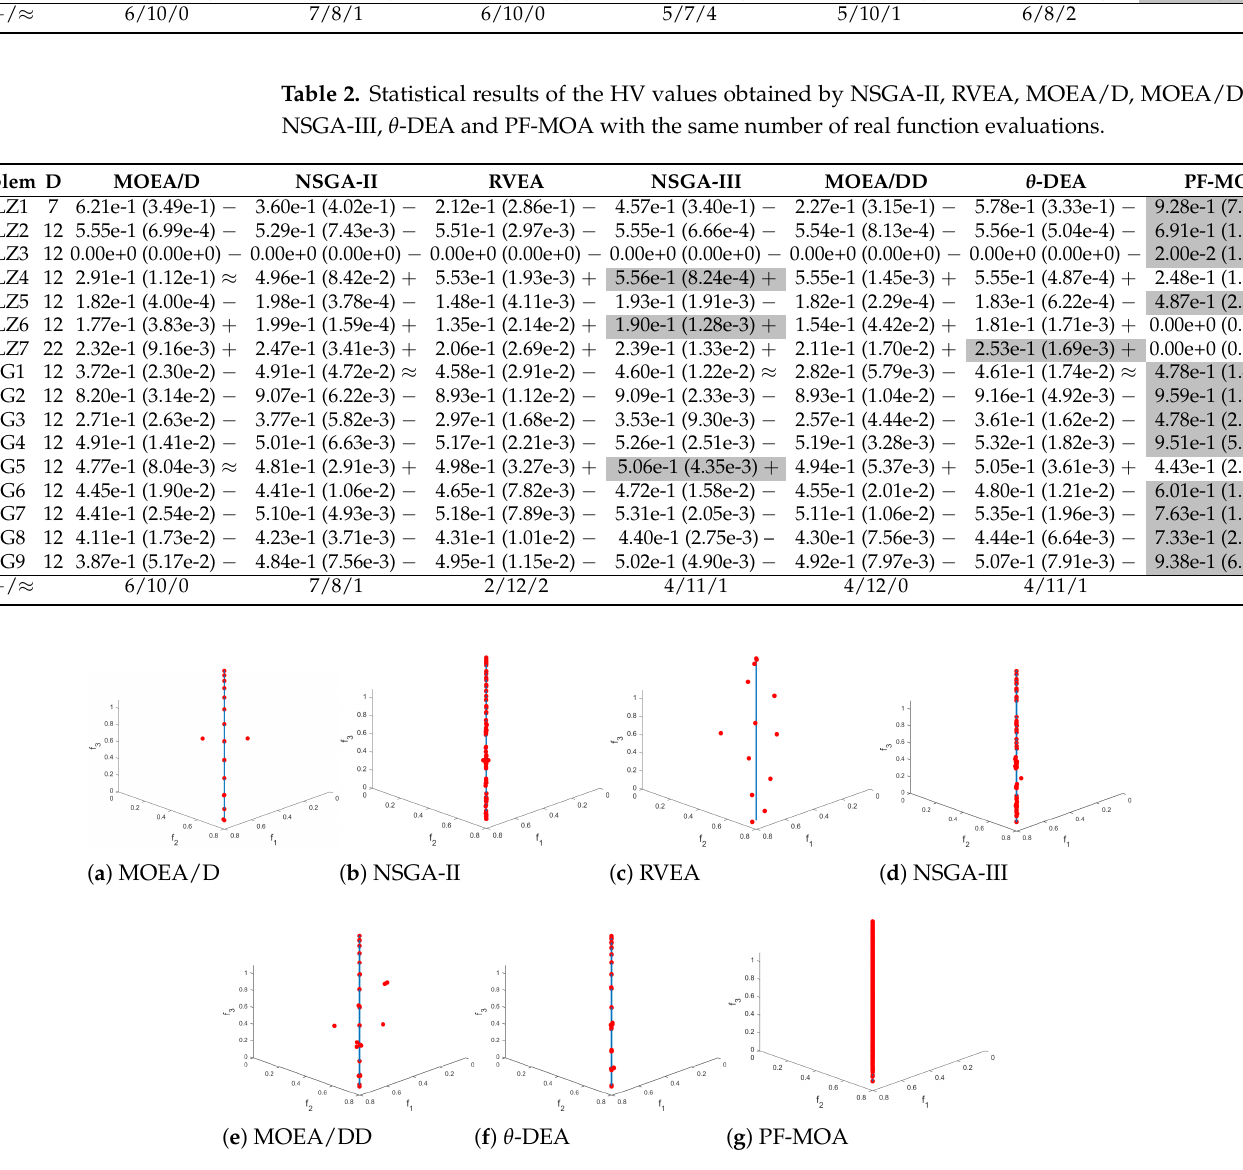
Figure 1. The Pareto front obtained by the compared algorithms on